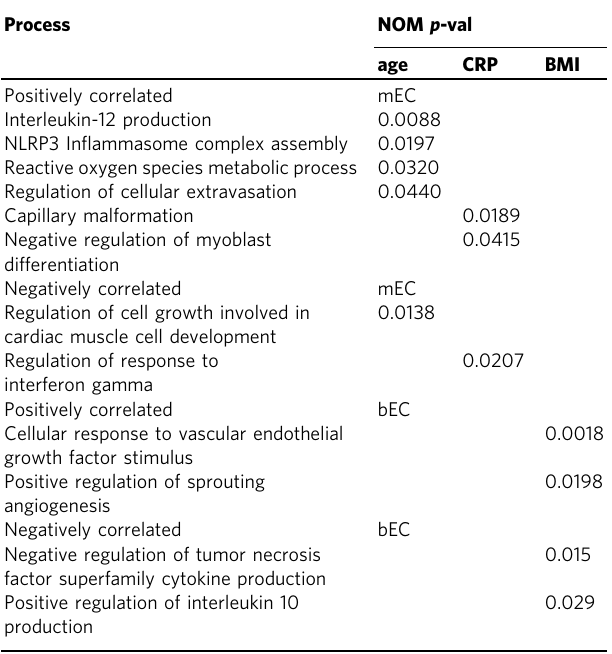
Data of OA patients with successful isolation of muscle and bone endothelial cells. Table 2 Correlation between GO processes and patient